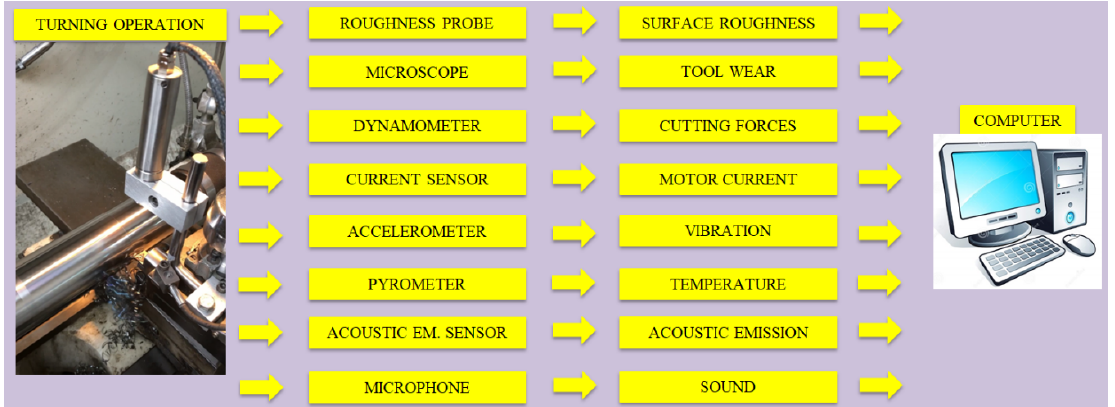
Figure 1. General outline of indirect tool condition monitoring system (TCMS) for turning.